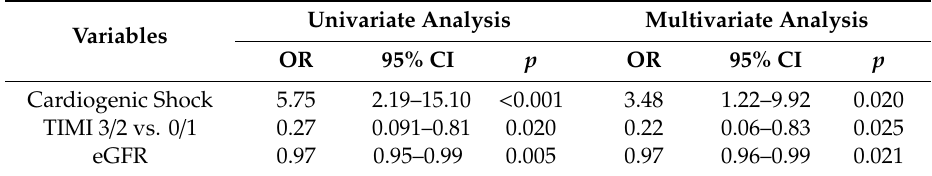
Table 3. Univariable and multivariable logistic analysis for the prediction of 1-year all-cause mortality. Model I: estimated glomerular filtration rate adjusted for cardiogenic shock and TIMI flow.